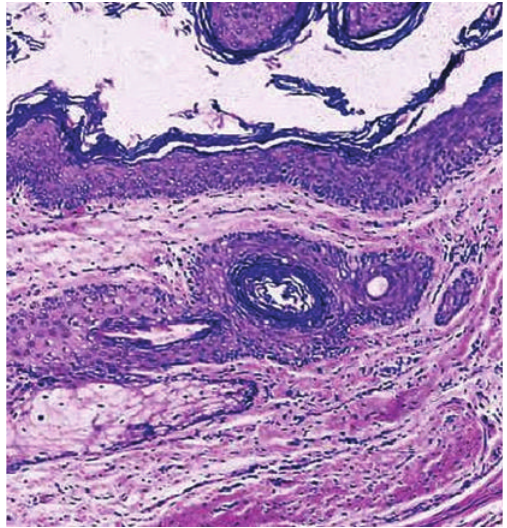
Figure 8: Keratinizing squamous epithelium with distinct granular layer with a sebaceous gland in the cyst wall.